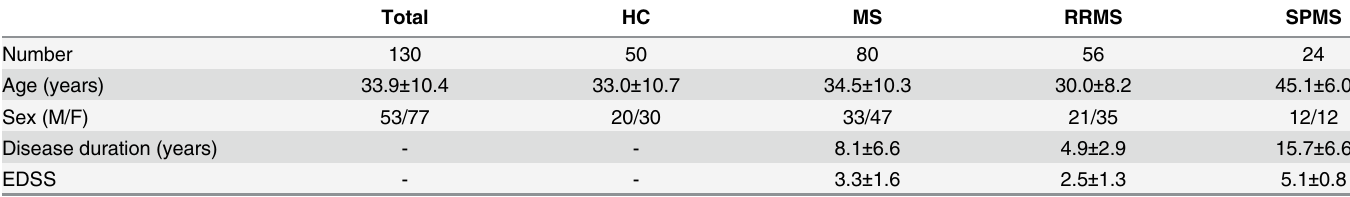
Table 1. Demographic and Clinical Characteristics of